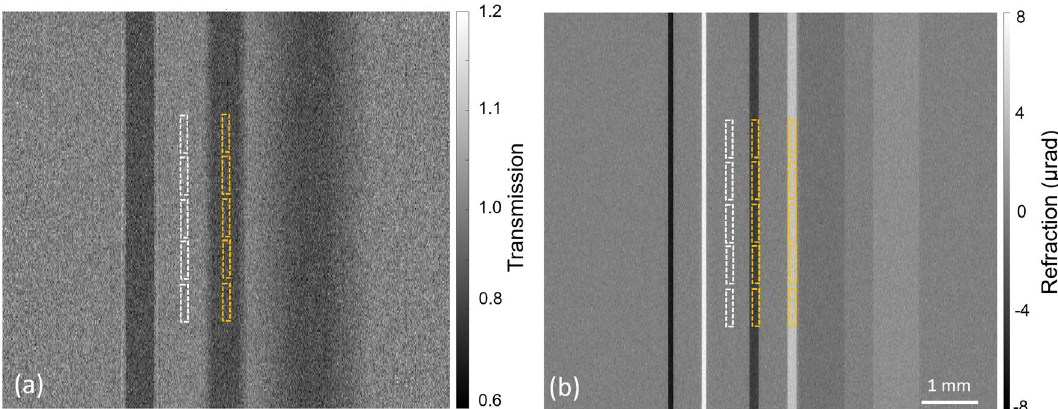
Figure 3. Examples of simulated images after attenuation ( a ) and refraction ( b ) signal extraction. Samples are three adjacent PMMA trapezoidal prisms with different inclinations 30 . The yellow and white dashed rectangles are the signal and background ROIs, respectively, which are used for SNR computation.